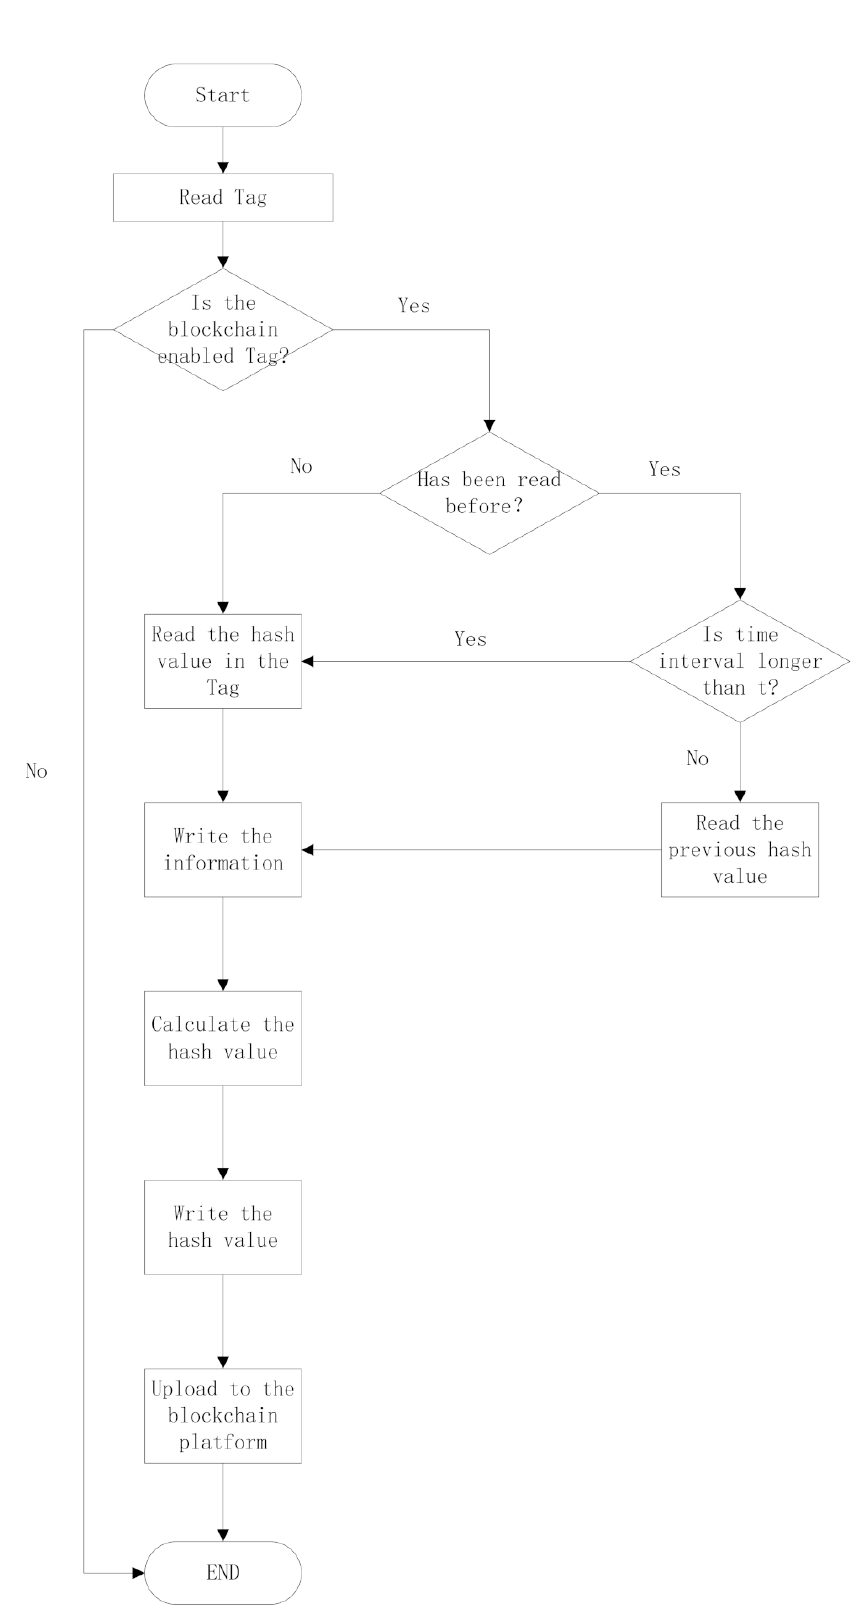
Figure 6. Workflow of the RFID